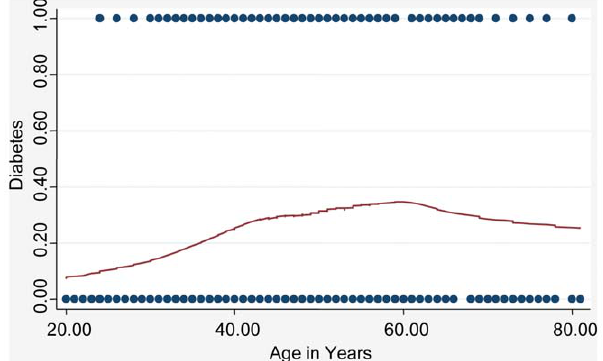
Figure 1. Non-linear association of diabetes and age. Lowess smoothing curve [10] fit to diabetes prevalence vs. age. A spline fit model (knot at age=50) is significantly different from a linear fit (p , 0.001).